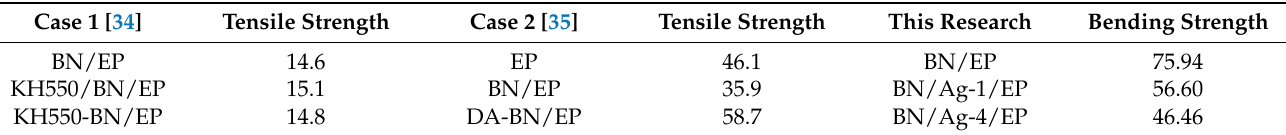
Table 2. Comparison of mechanical properties of composites with experimental data of others.